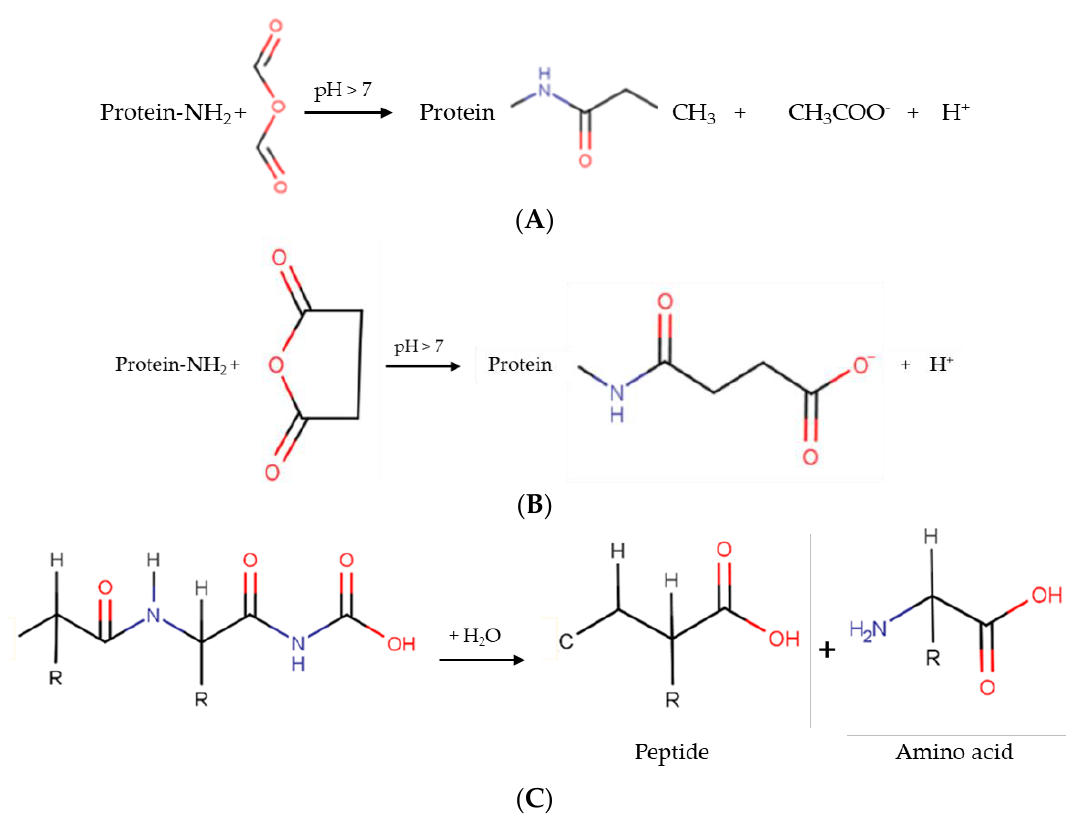
Figure 2. Schematic representation of the main chemical protein modification reactions. ( A ) Acetylation, ( B ) succinylation and ( C ) hydrolysis.